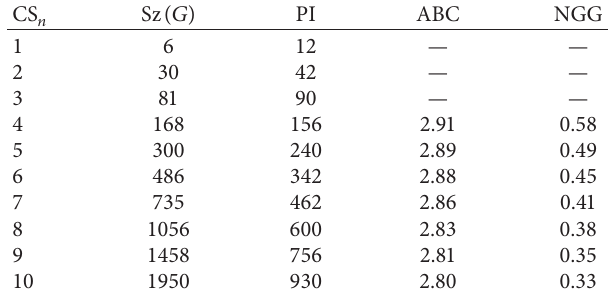
Table 26: Comparison table for chain silicate.